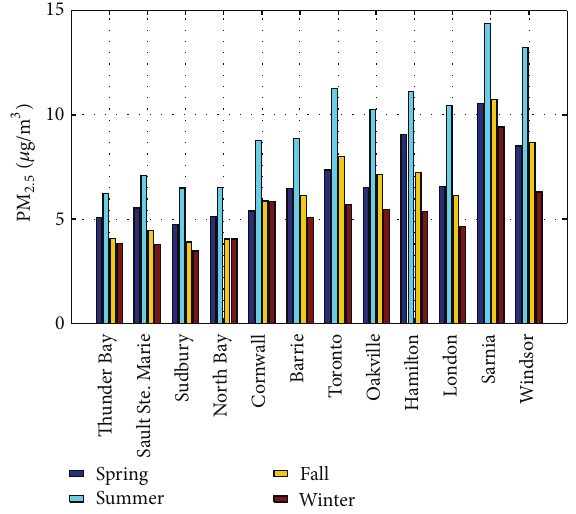
Figure 3: PM 2.5 concentrations ( 𝜇 g/m 3 ) in spring (March, April, and May), summer (June, July, and August), fall (September, Octo- ber, and November), and winter (December, January, and February) atthe12Ontariancitiesin2006.Thecitiesareorderedbydescending latitude (see Table 1 and Figure